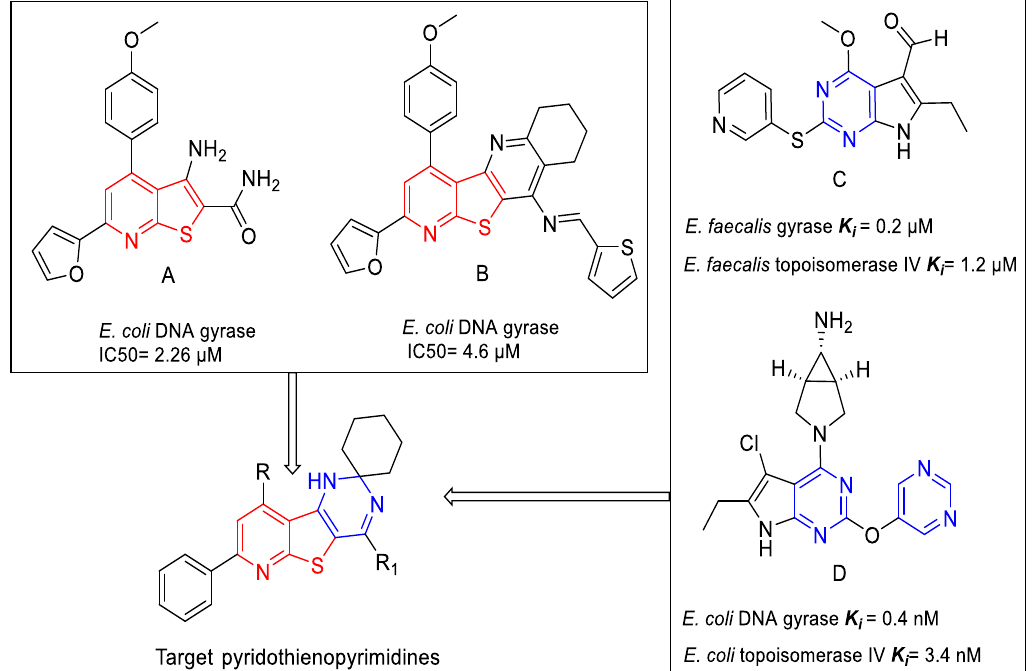
Figure 1. Recently discovered thienopyridines ( A , B ) and pyrimidine–based compounds ( C , D ) as bacterial type II topoisomerase inhibitors and the design of the target heterocyclic ring system.